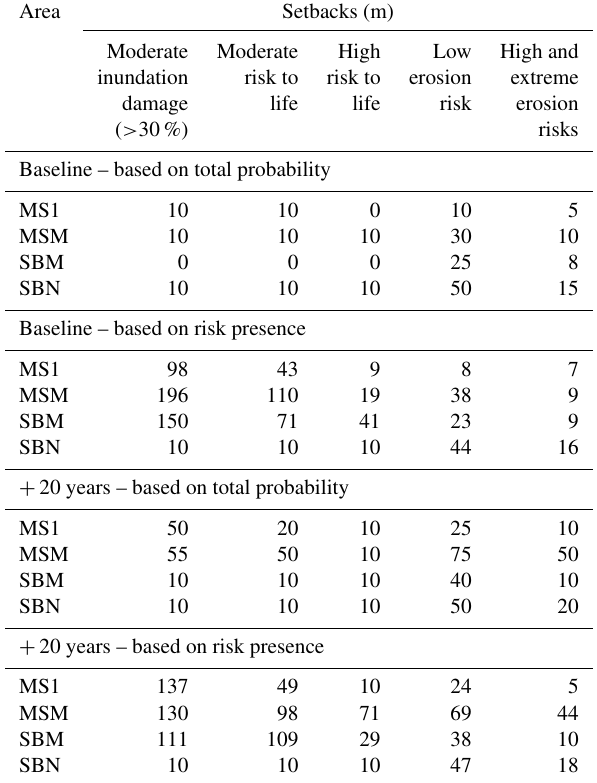
Table 7. Characterisation of setbacks for different hazards and risk levels in the Tordera delta. Baseline scenario and + 20-year time horizon using two approaches: (i) total probability, i.e. natural vari- ability of the storm climate with the spatial variability of the impacts on receptors; and (ii) risk presence, i.e. focusing only on the spatial distribution of receptors under that